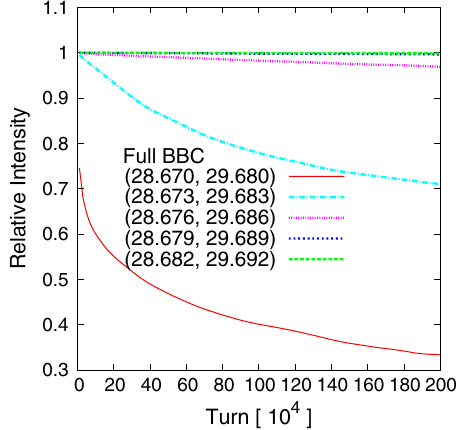
FIG. 20. Proton beam loss of full head-on beam-beam com- pensation in the tune scan. The bunch intensity is 2 : 5 (cid:2) 10 11 . The betatron phase adjustment and the global second order chromaticity correction are